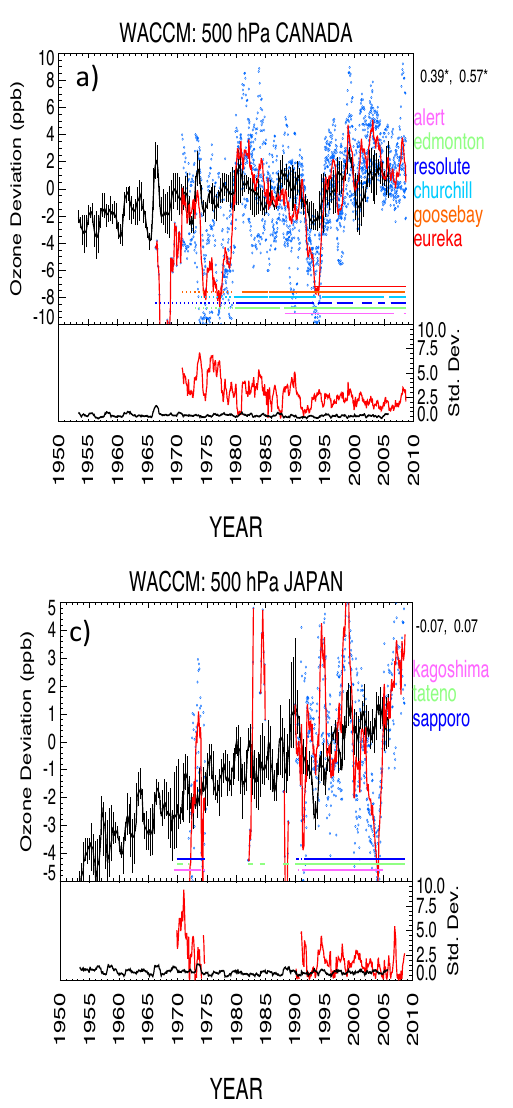
Figure 4. As in Fig. 3 but at 500hPa averaged over (a) the Canadian ozonesonde sites, (b) the central 500hPa European ozonesonde sites, (c) the Japanese ozonesonde sites and (d) the northern European ozonesonde